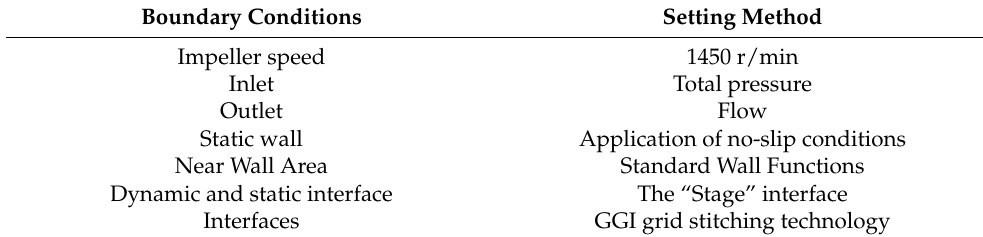
Table 3. Calculation settings of the main components of the axial flow